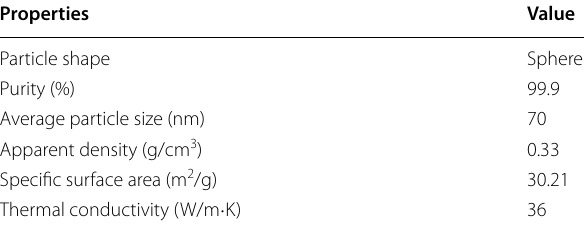
O nanoparticles 2 3